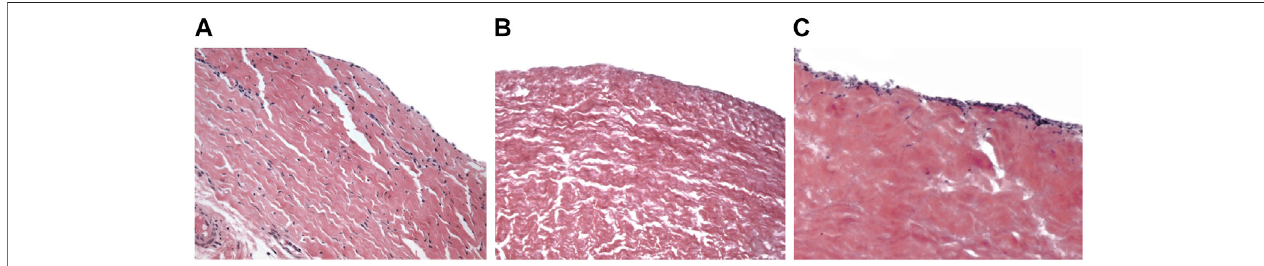
FIGURE 8 | Hematoxylin and eosin staining of native bovine pericardium (A) and decellularized bovine pericardium before (B) and after (C) 7 days of culture with bovine fi broblasts. Magni fi cation × 20 [from (Cigliano et al., 2012)].